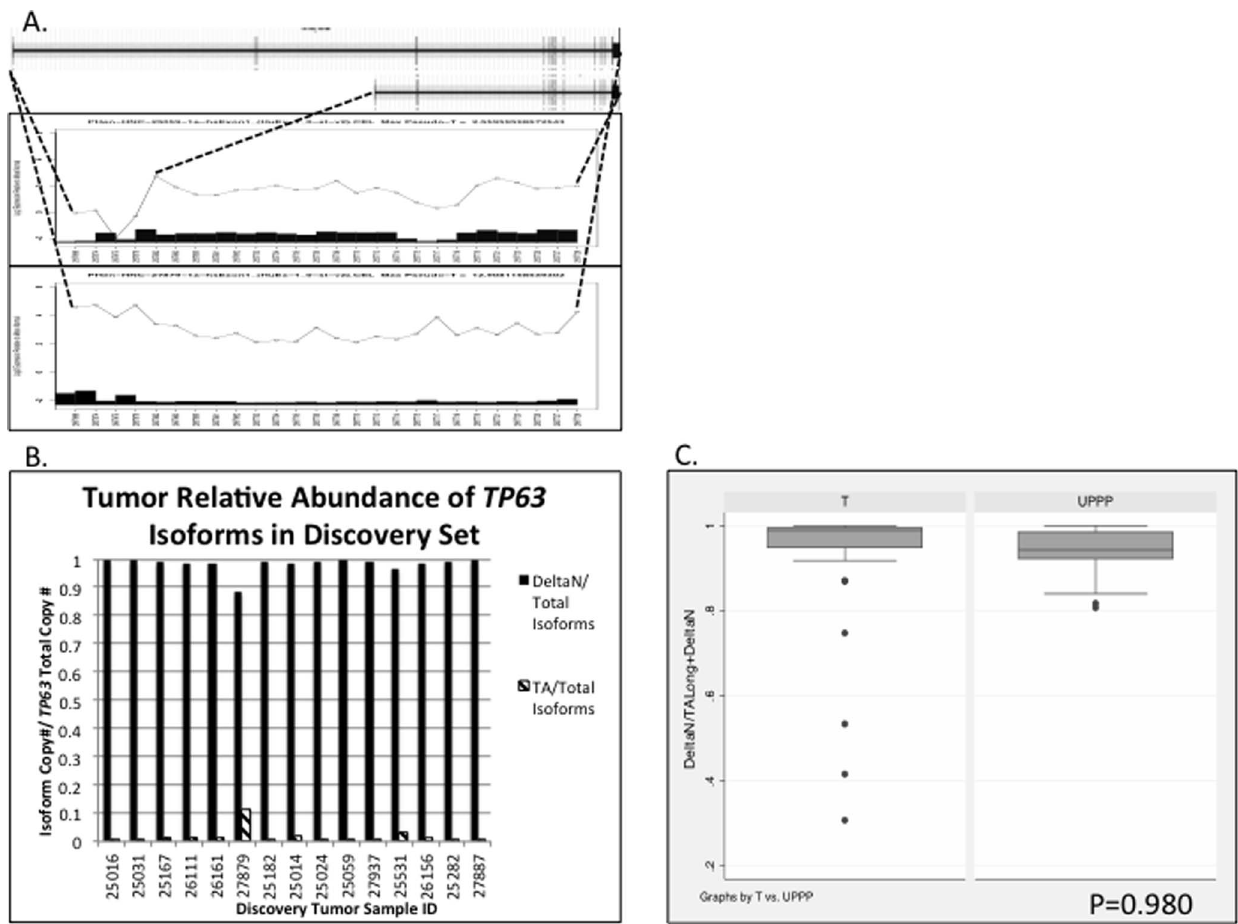
Figure 3. Splice variants of TP63 demonstrated in exon array analysis (A) and quantitative RT-PCR validation (B and C). A, Example of discovery HNSCC primary tumor samples predicted to have dominant expression of TAp63 (long) and DeltaNp63 (short) isoforms, respectively. Uppermost box displays all exons for long and short isoforms of TP63 . Middle and lower boxes display exon-specific array probesets along horizontal axis, and probeset signal relative to normal (0) on the vertical axis, log 2 scale . For each probeset, the inset histograms display the number of standard deviations from the mean probeset signal in UPPP samples, that the probeset signal deviates in each individual tumor. B, Splice index calculations [Absolute Copy # of TP63 isoform / ( TAp63 + DeltaNp63 )] in 15 discovery tumor samples. C, Comparison of mean splicing index for TP63 isoforms in an independent validation set of 47 HNSCC tumors vs. 19 UPPP samples, two-tailed Student’s t test, P=0.980 .